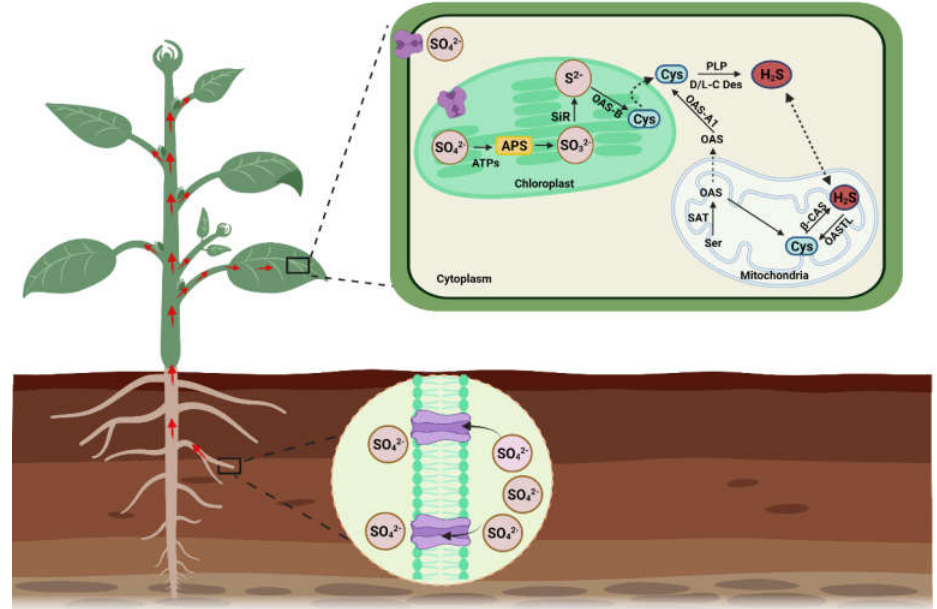
Figure 2. H 2 S biosynthesis in plants. In plants, sulfate (SO 42− ) is transported from the roots, which is then distributed to all parts of the plant through the xylem vessels. SO 42− entering the cells is assimilated in the chloroplasts and mitochondria. In chloroplast, SO 42− is reduced to sulfite (SO 32− ) by APS reductase after it is activated to APS. Under the catalysis of SiR, the sulfite is then reduced to sulfide (S 2− ) using six electrons transferred from ferredoxin. As a result, sulfide is produced, which is used to produce cysteine. The OASTL enzyme catalyzes the synthesis of cysteine along with O-acetylserine. The enzyme CDes and pyridoxal 5-phosphate (PLP) participate in degrading cysteine to generate H 2 S. In mitochondria, serine acetyltransferase (SAT) catalyzes the conversion of serine (Ser) into OAS and produces cysteine, which is converted to H 2 S via the catalytic activity of β-cyanoalanine synthase (β-CAS).